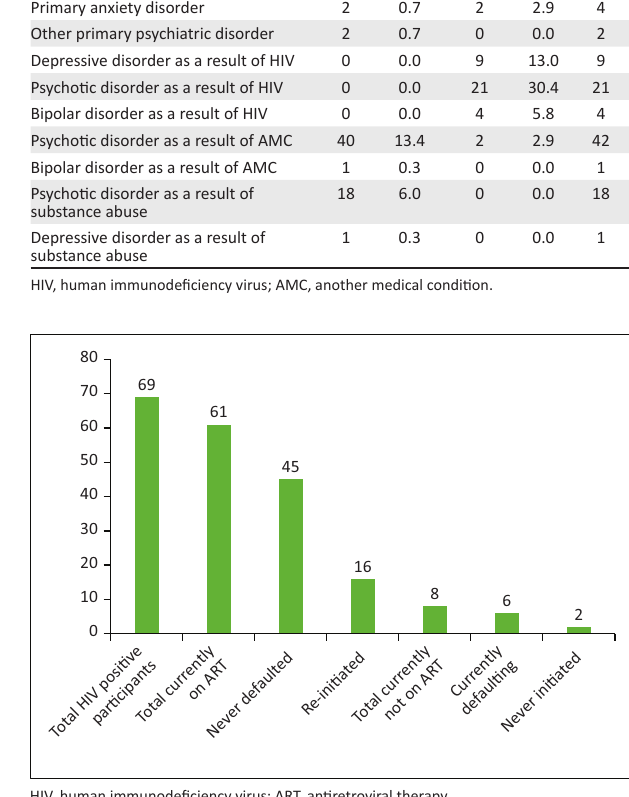
FIGURE 2: Linkage to care and ART